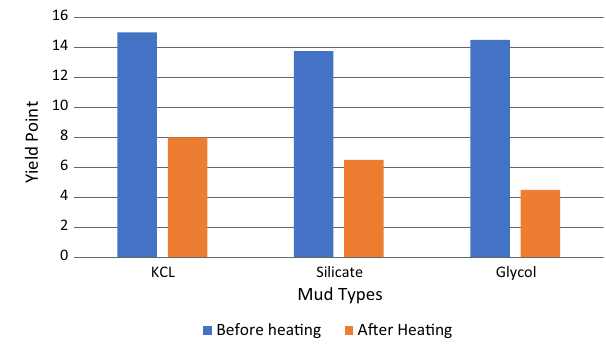
Fig. 1 Apparent viscosity for different drilling fluids